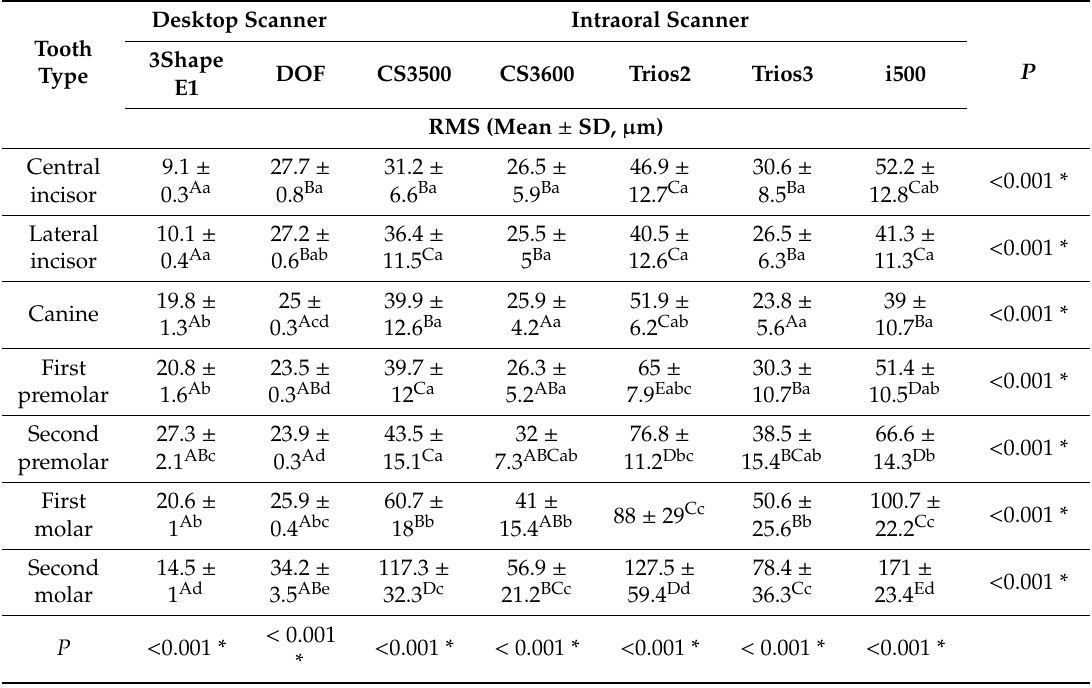
*Different capital letters (row) and lowercase letters (column) indicate that the differences between the groups are significant by Tukey’s HSD post hoc testing ( P < 0.05).